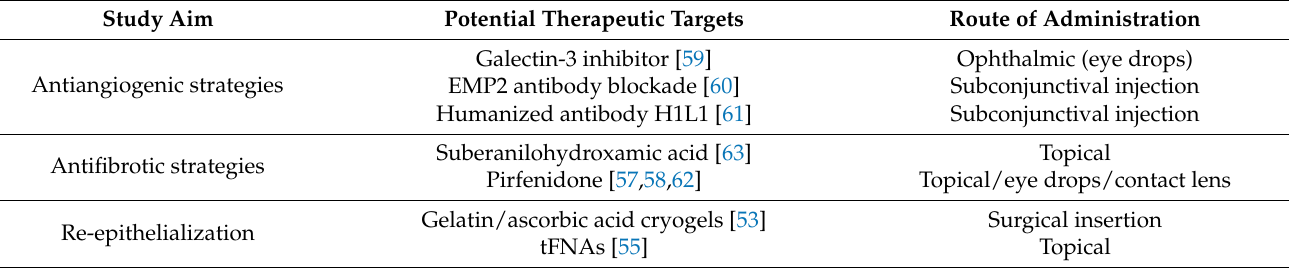
Table 4. Experimental strategies for the treatment of corneal